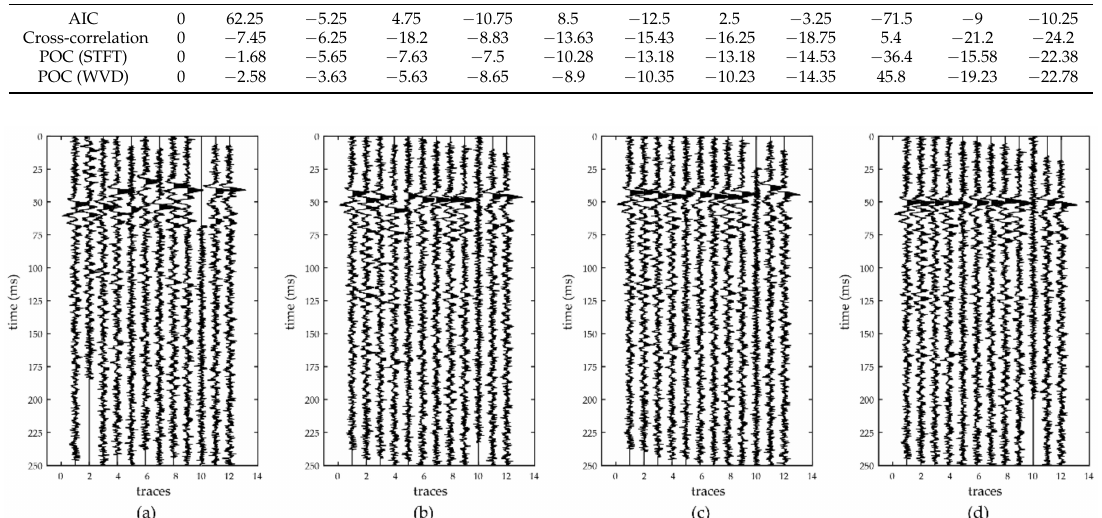
Table 7. The estimated values of the relative arrival times of the second noisy dataset (SNR = 0 dB). Methods